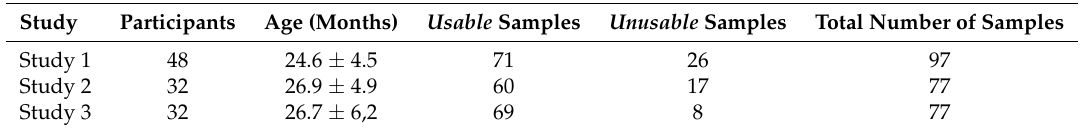
Table 1. Participants’ demographic information and number of usable and unusable samples per Study included in this work.